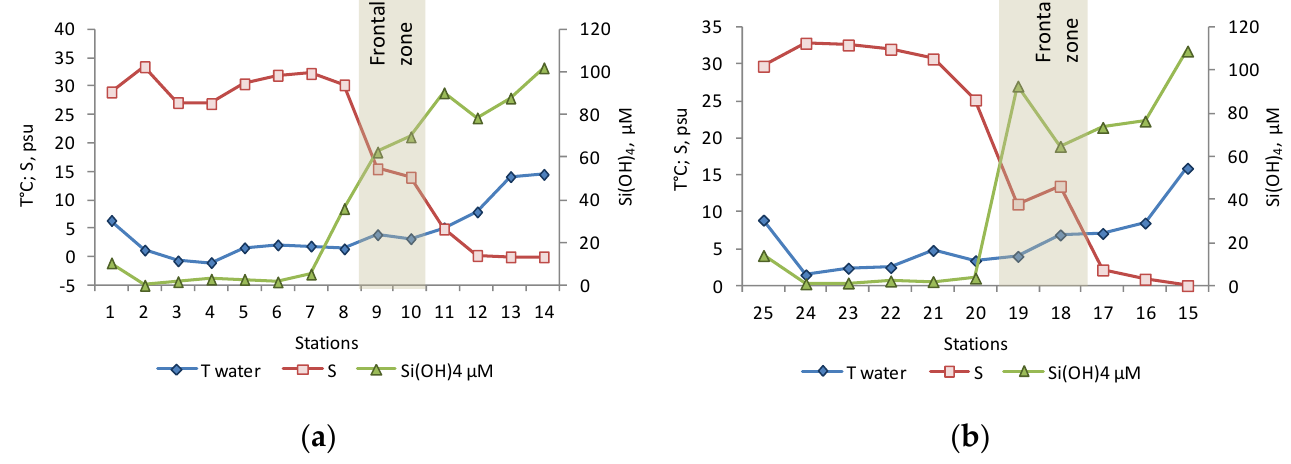
Figure 2. Distribution of surface temperature (T, °C), salinity (S, psu), and silicate concentration (Si(OH) 4 , μM) in the study area at stage 1 ( a ) and stage 2 ( b ).